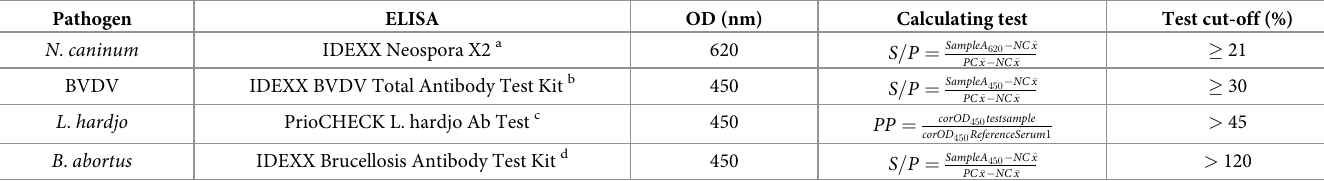
Table 2. Enzyme-linked immunosorbent assays (ELISA) used for the determination of antibodies against Neospora caninum , bovine viral diarrhoea virus (BVDV), Leptospira interrogans serovar Hardjo ( L . hardjo ) and Brucella abortus in cattle and buffalo sera from Lao PDR.